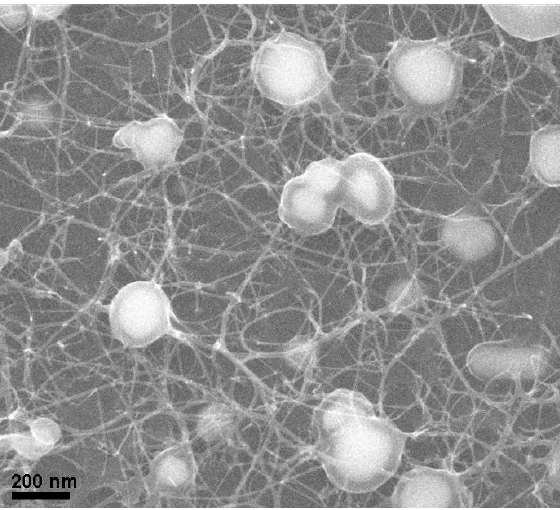
Figure 2. SEM micrograph of the SWCNT networks for gas sensing.